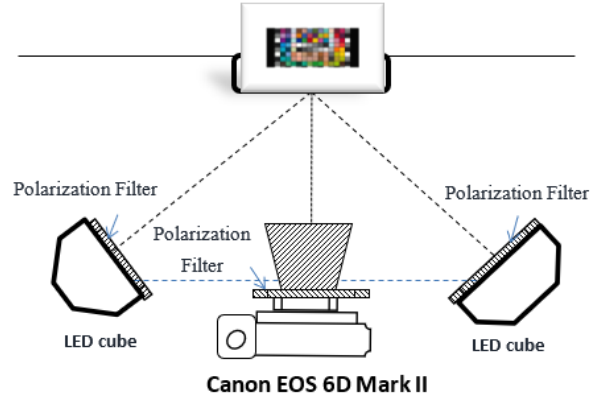
Figure 1. The system setting of the image acquisition.